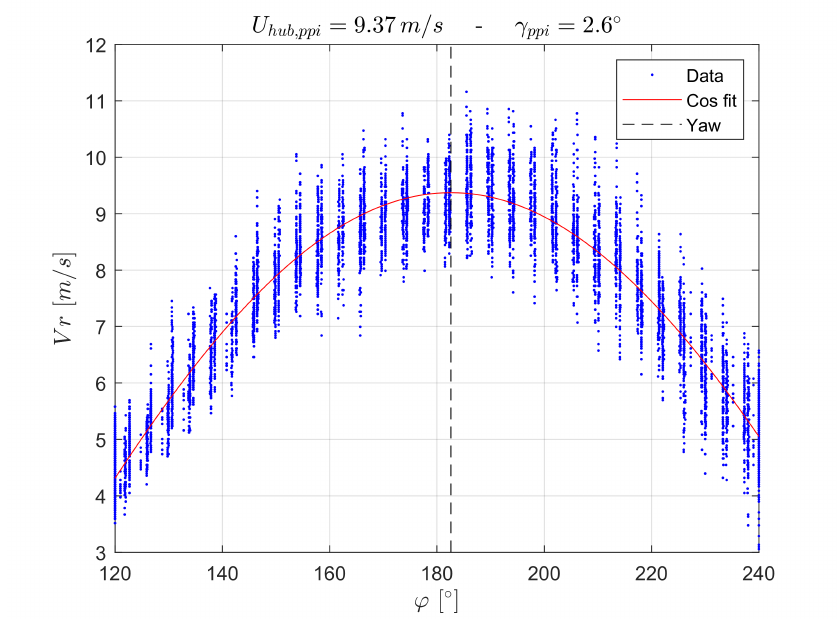
Figure 5. Example of the estimation of the yaw angle and the horizontal wind speed at hub height with plan position indicator (PPI) scans. Data corresponding to the period 22h30–22h35, 15 September